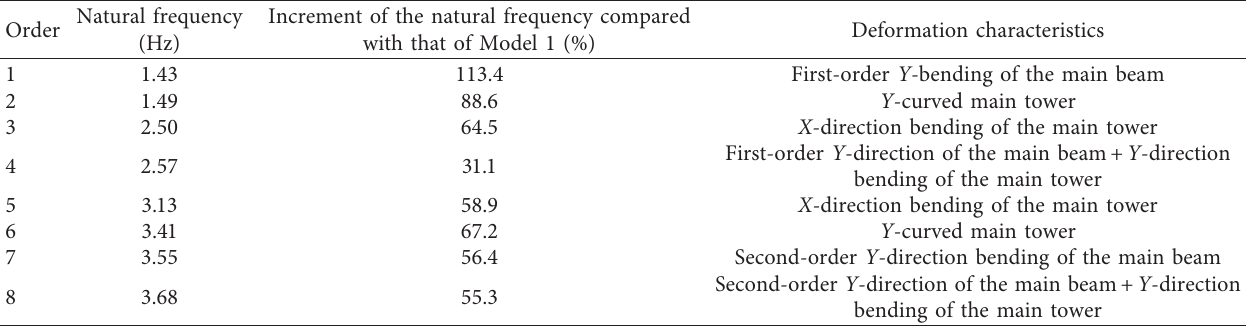
Table 5: The natural frequency and deformation characteristics of Model 5.